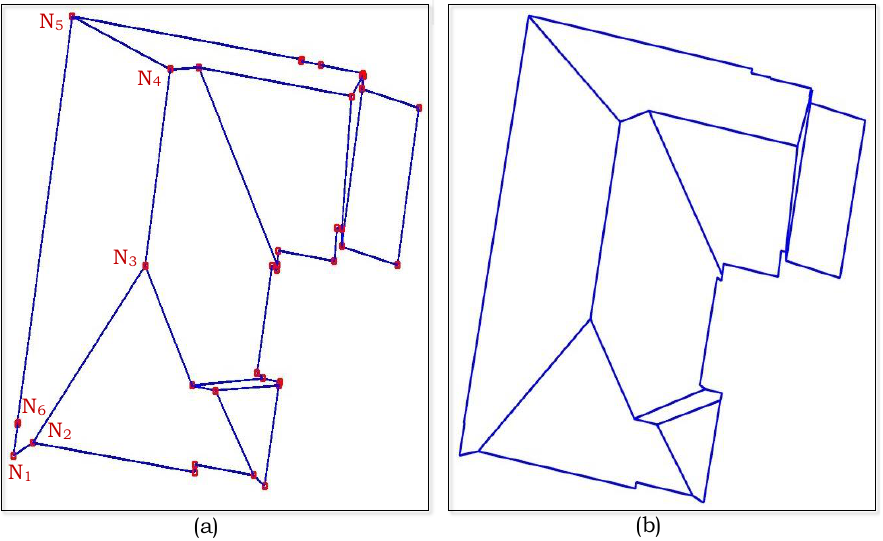
Figure 6. Individual roof segments and building model: ( a ) a roof segment is shown with a sequence of ridge and edge points ( N 1 to N 6 ); and ( b ) roof model of the sample